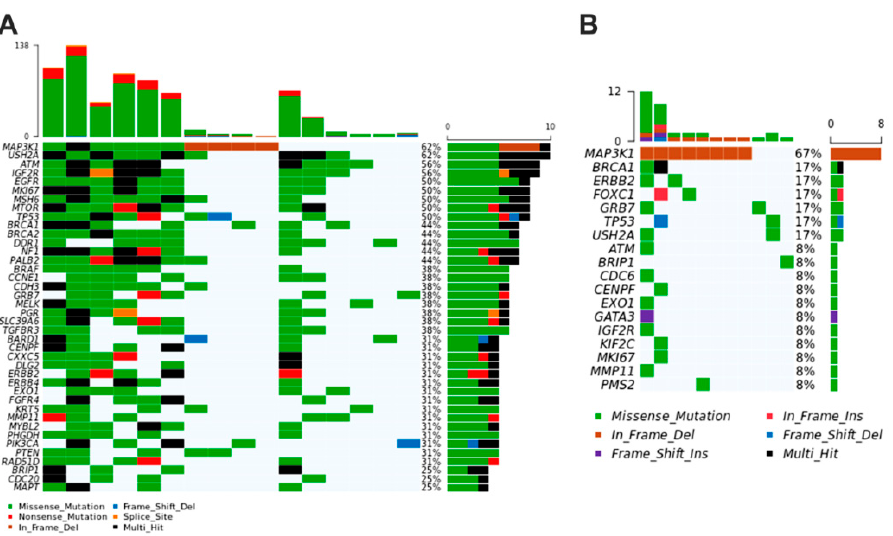
Figure 6. Oncoplots depicting the distribution of most representative variants in BC-associated genes regarding the individual tumor fragments ( A ) and plasma samples ( B ) of women. The upper plot shows the frequency of mutation for each tumor sample and lower left plots exhibit the mutations in each tumor sample (most deleterious mutation types are shown). The lower right plots indicate the frequency of samples mutated in fragments and plasma of patients. Graphics were generated from the R language, using the Maftools package.